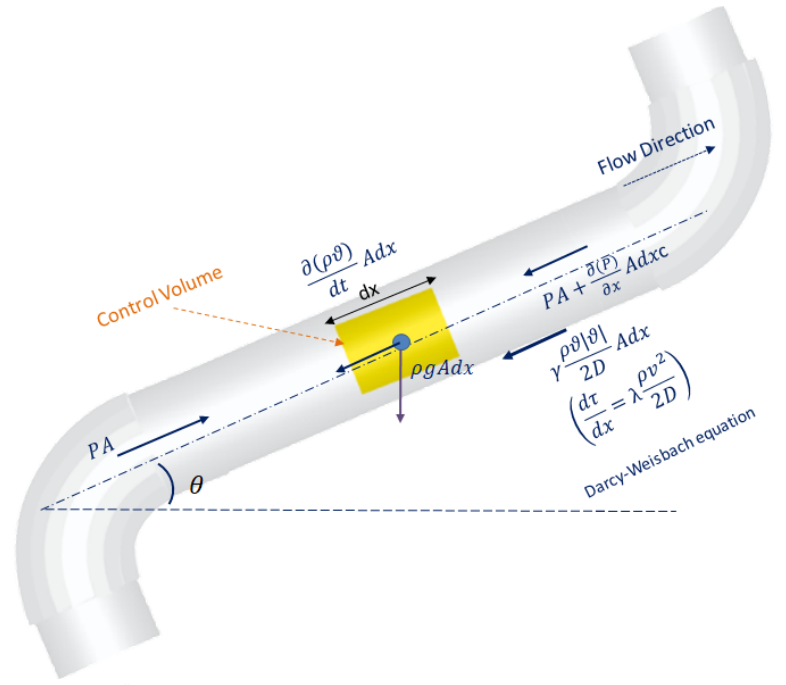
Figure 1. Forces effective on a specific volume of gas flow through a